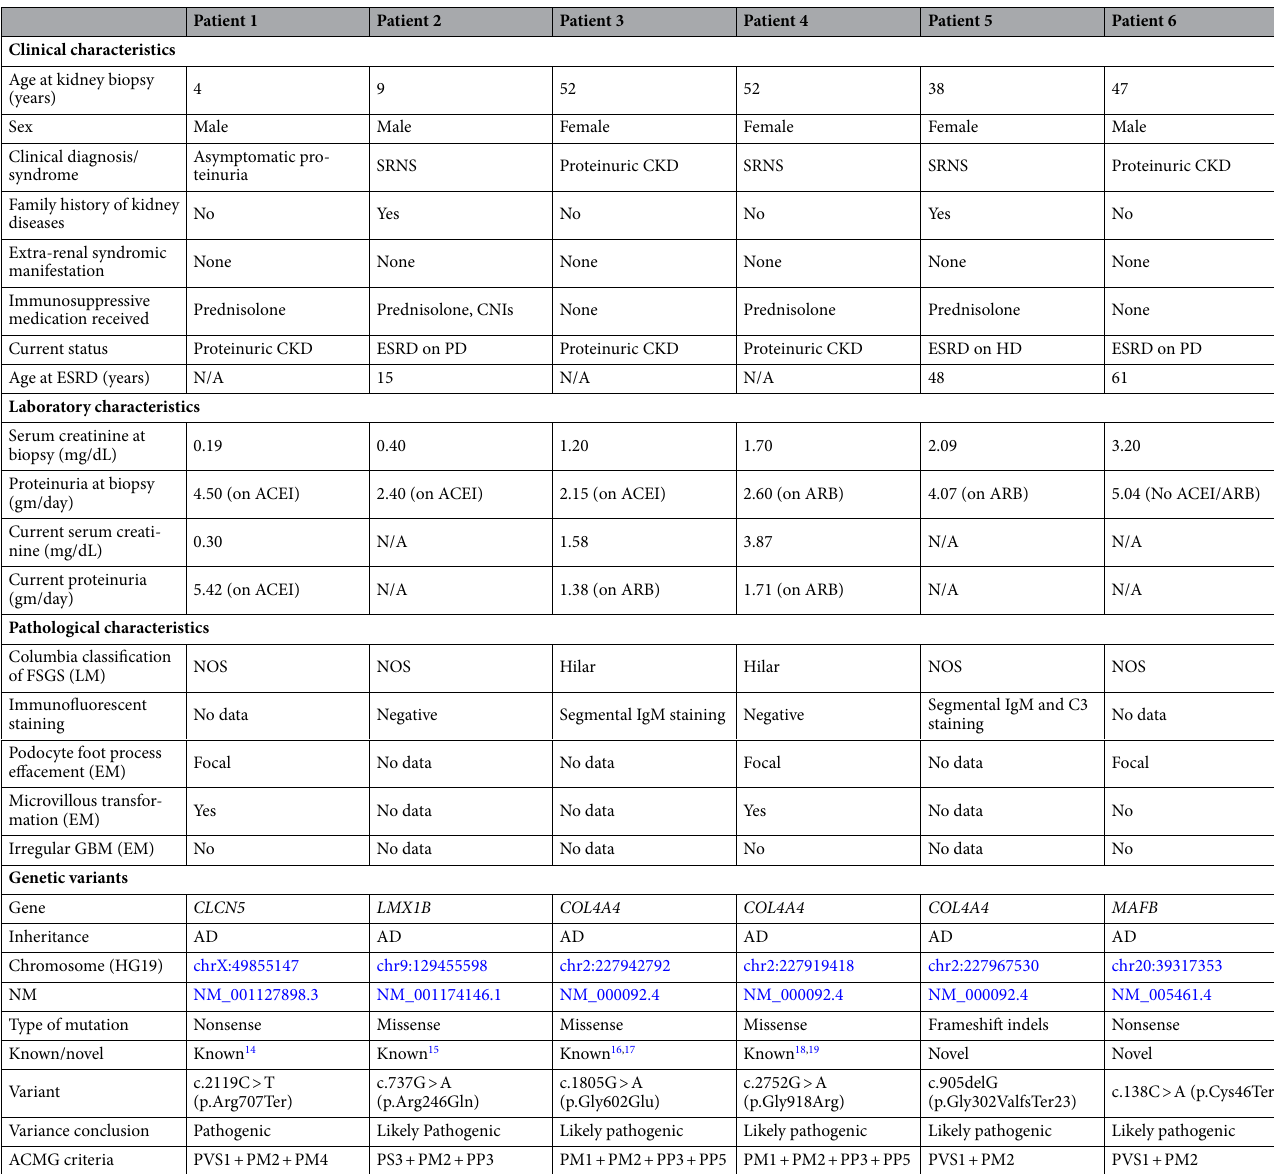
Table 2. Clinical, laboratory, pathologic characteristics, and genetic variants of patients with pathogenic or likely pathogenic mutations. ACEI angiotensin-converting enzyme inhibitors, ACMG American College of Medical Genetics and Genomics, AD autosomal dominant, ARB angiotensin receptor blockers, CKD chronic kidney disease, EM electron microscopy, ESRD end-stage renal disease, IgM immunoglobulin M, FSGS focal segmental glomerulosclerosis, GBM glomerular basement membrane, HD hemodialysis, NOS not otherwise specified, PD peritoneal dialysis, SRNS steroid-resistant nephrotic